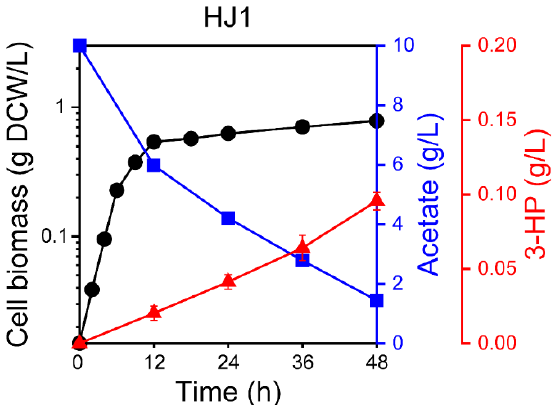
Figure 2. Time-course fermentation profile of the HJ1 strain. The left y-axis, right y-axis and right y-offset represent the cell biomass (g DCW/L), acetate (g/L) and 3-HP (g/L), respectively. The x-axis denotes time (h). Symbols: circles, cell biomass; squares, acetate; triangles, 3-HP. The error bars indicate standard deviations for measurements from three independent cultures. One OD 600 unit corresponds to 0.31 g dry cell weight (g DCW/L).